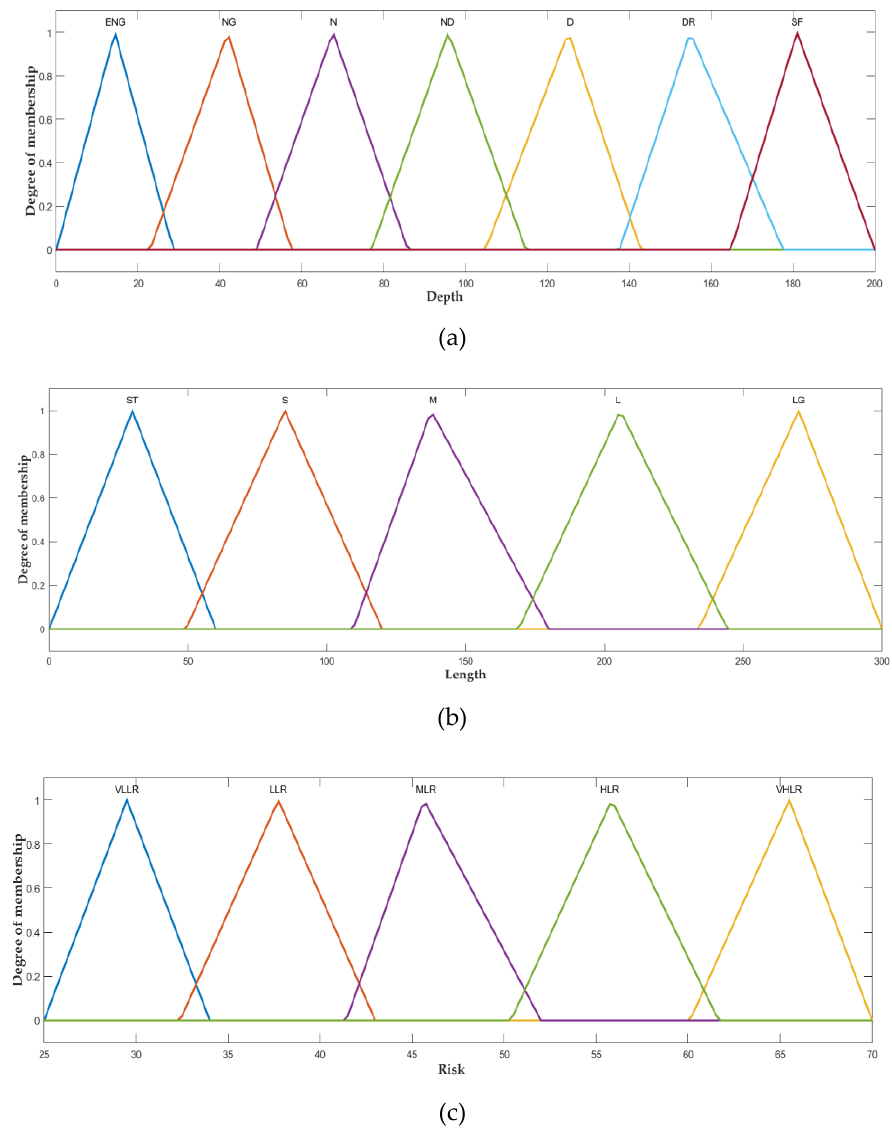
Figure 4. Input/output MFs for FIS_1 of the proposed CHFIS model, ( a ) depth;( b ) length; ( c ) risk.